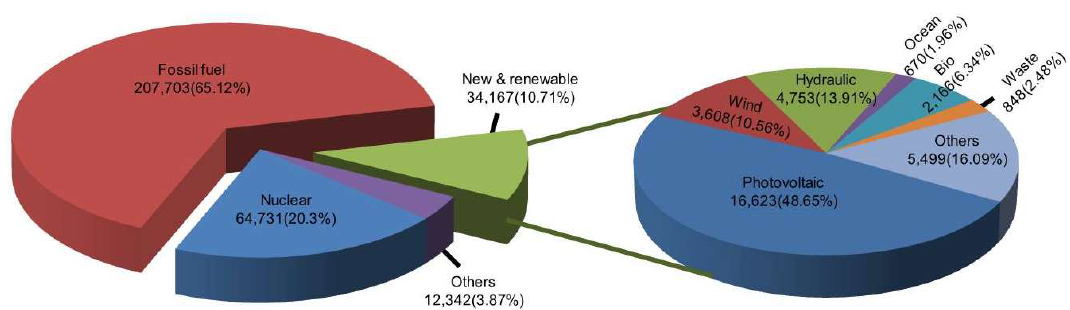
Figure 1. 2018 power supply outlook in Korea (GWh) [8].